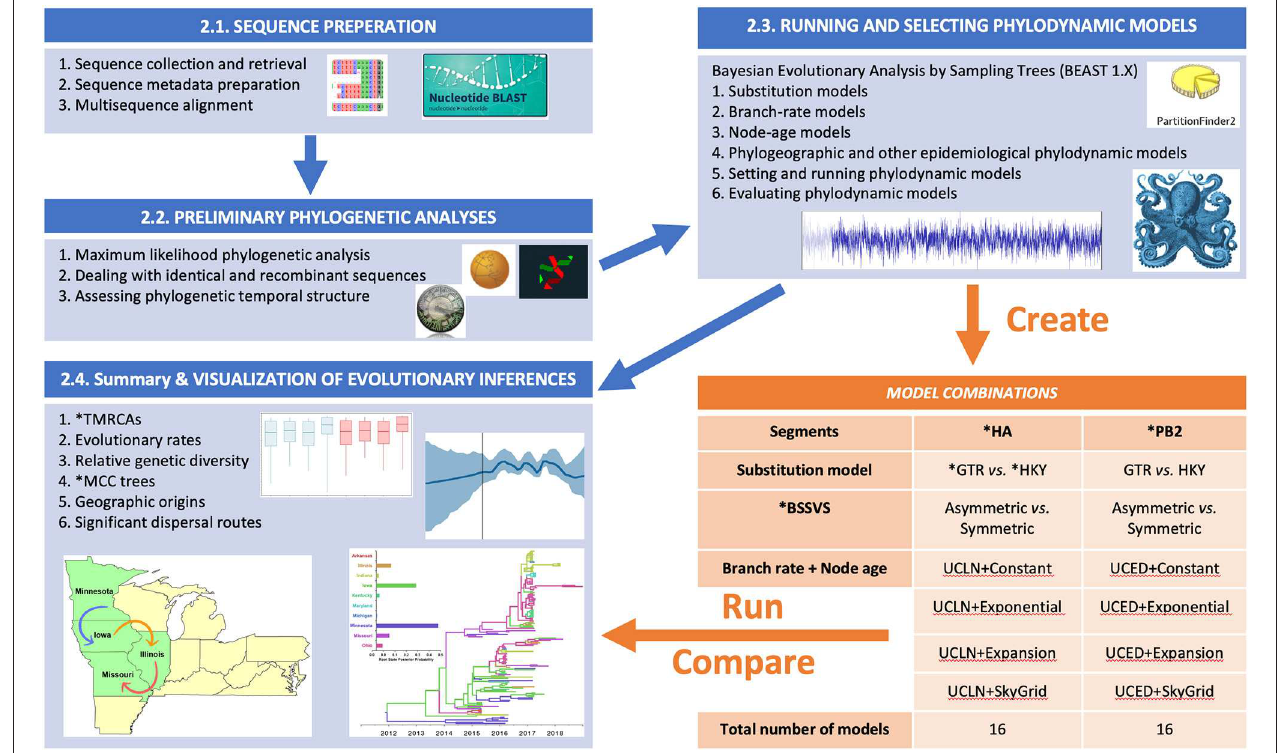
FIGURE 1 | Flow chart showing the steps for our Bayesian phylodynamic statistical framework. Blue boxes summarize the methodological steps for the statistical framework described in the BAYESIAN PHYLODYNAMIC STATISTICAL FRAMEWORK section of the main text (Sequence Preparation section to Summary and Visualization of Evolutionary Inferences section). The orange table indicates the generated models for swine influenza example data described in Section Worked Example: Evolutionary Dynamics of Swine Influenza in the United States Between 2015 and 2018. ML, maximum likelihood; RDP, Recombination Detection Program; ESS, effect sample size; BF, Bayes factor; PS, path sampling; SS, stepping stone; HA, hemagglutinin; PB2, polymerase basic 2; GTR, general time-reversable; HKY, Hasegawa, Kishino, and Yano; BSSVS, Bayesian Stochastic Search Variable Selection; TMRCAs, Time to the Most Recent Common Ancestor; MCC, Maximum Clade